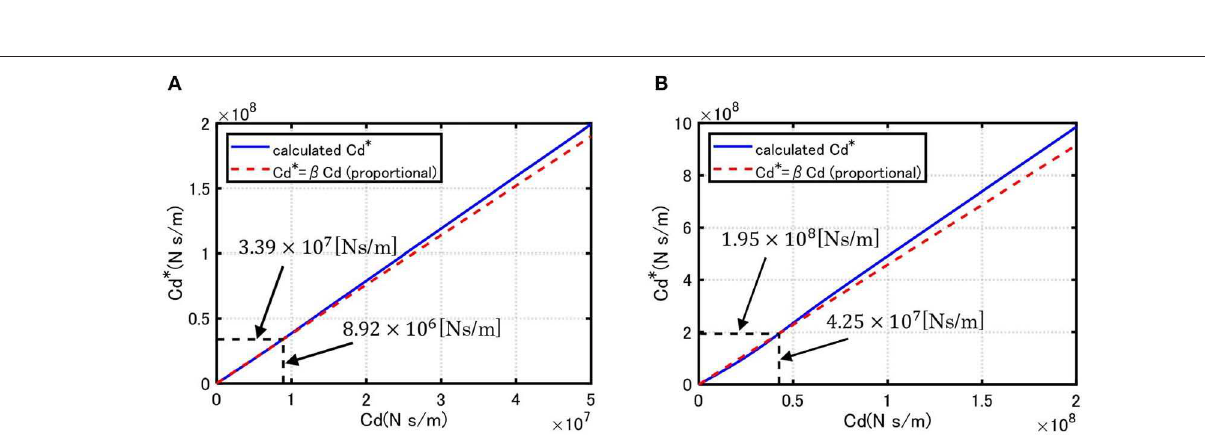
Frontiers in Built Environment |